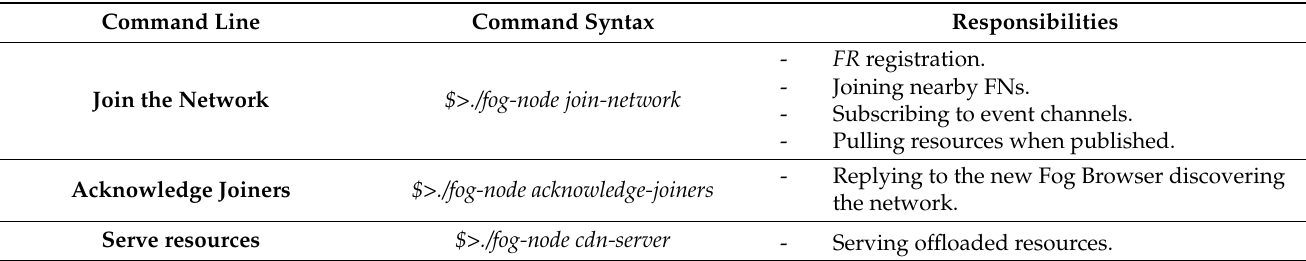
Table 1. A summary of the FW different